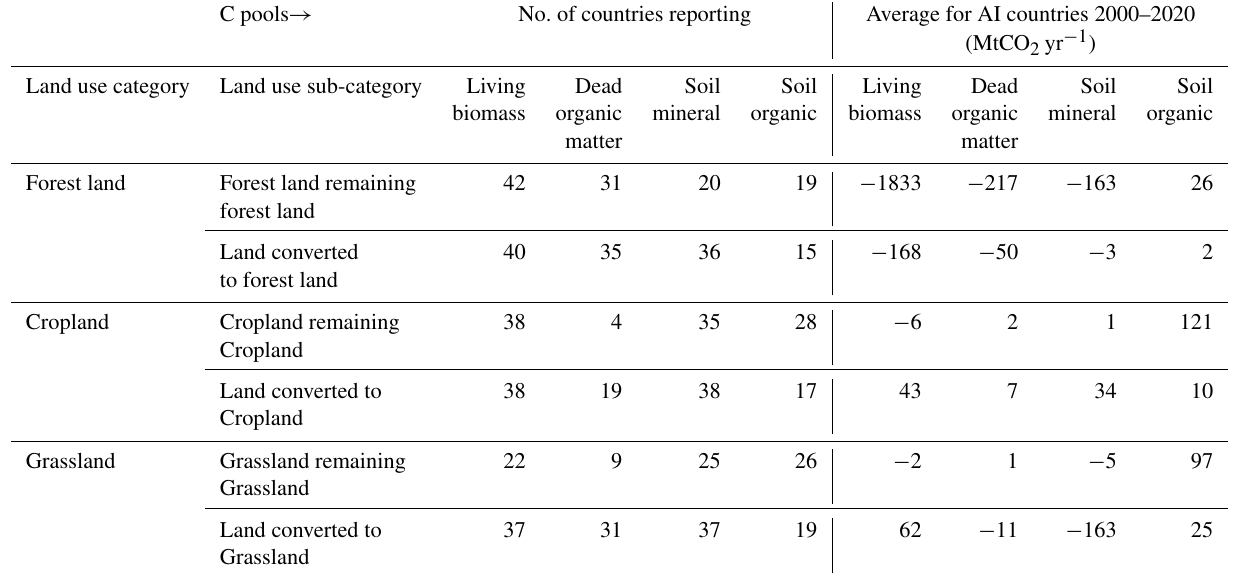
Table 5. Statistics on carbon pools (number of countries reporting, average CO 2 fluxes) for the main land use categories and sub-categories in the NGHGIs of AI countries.